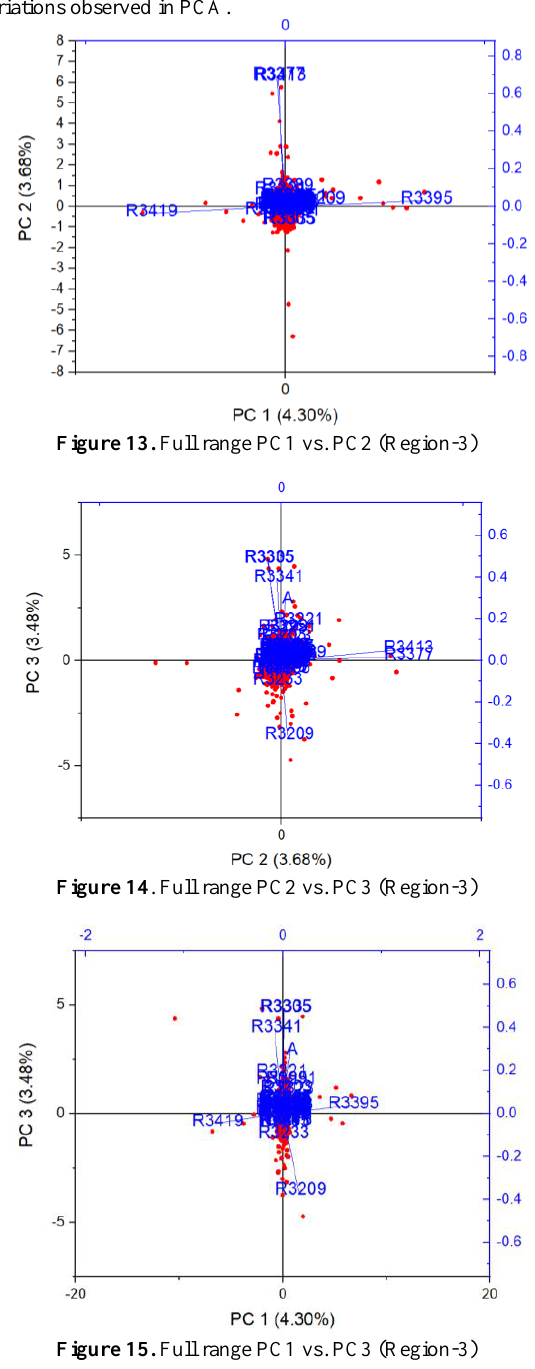
Figure 15. Full range PC1 vs. PC3 (Region-3)